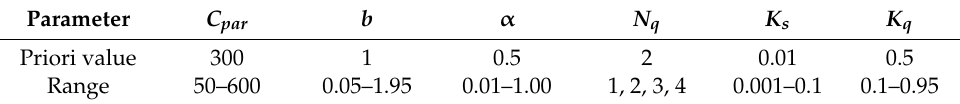
Table 1. A priori parameter set and feasible parameter ranges.